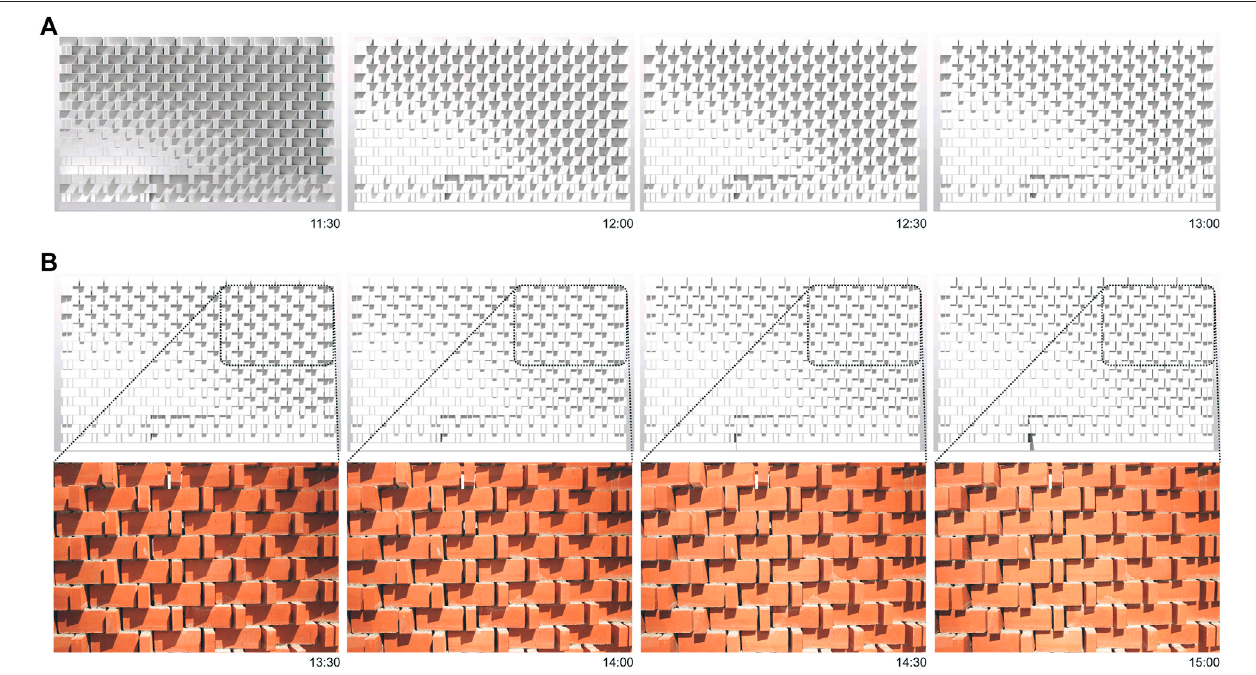
FIGURE 7 | Shadow casting simulation of the self-shading effect during a sunny day on August 7th: (A) The orientation of the rotated bricks provides self-shading effects especially in the morning hours and prevent the wall to heat up during day. (B) The afternoon images, taken on 7 August 2020 and the matching visualization for the same times and date proof the assumptionsgained from the solar radiation simulation and the casting simulation. Theself-shadingeffectdecreases in theafternoon due to the sun ’ s movement.